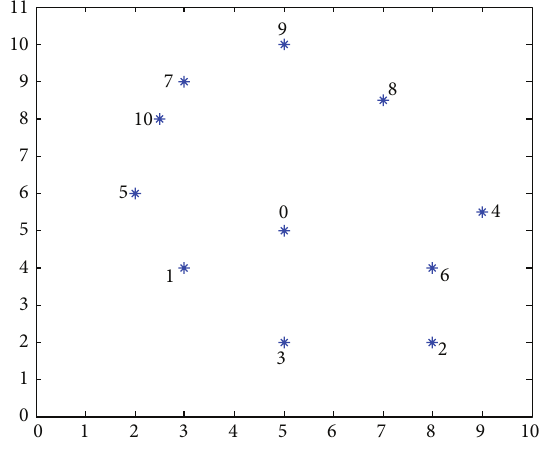
Figure 3: The position relationship of the